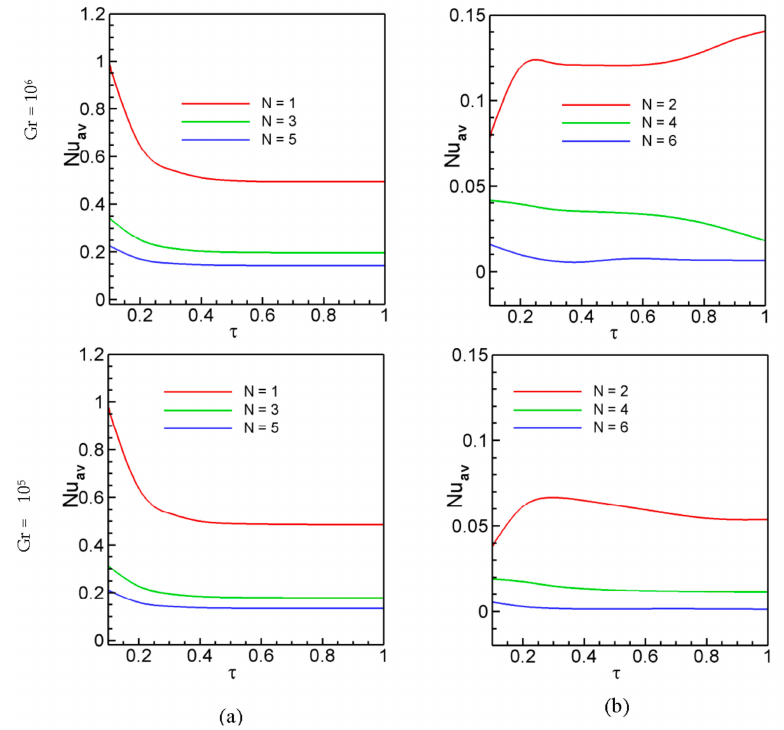
Figure 16. Variation of the overall Nusselt number for ( a ) odd values of N and ( b ) even values of N